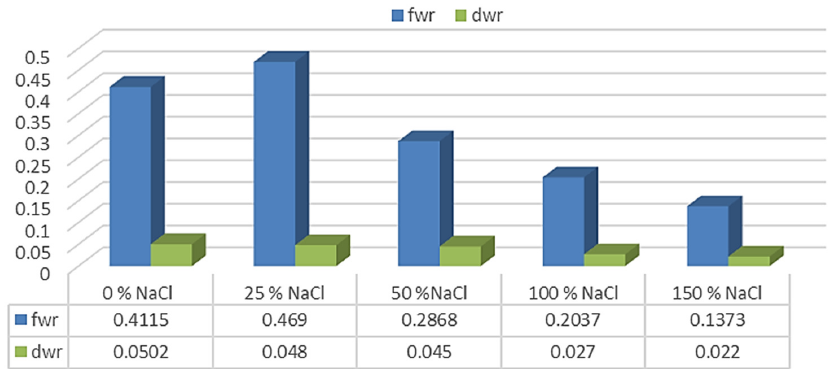
Figure 7. Effect of salt stress on fresh weight radicle (FWR) and dry weight radicle (DWR) Table 2. Variation table on average o number of seed germinated (number), germination rate (%), average germination time, fresh and dry weight of coleoptile (g), fresh and dry weight of the radicle (g) between each other and salinity concentrations (NaCl)